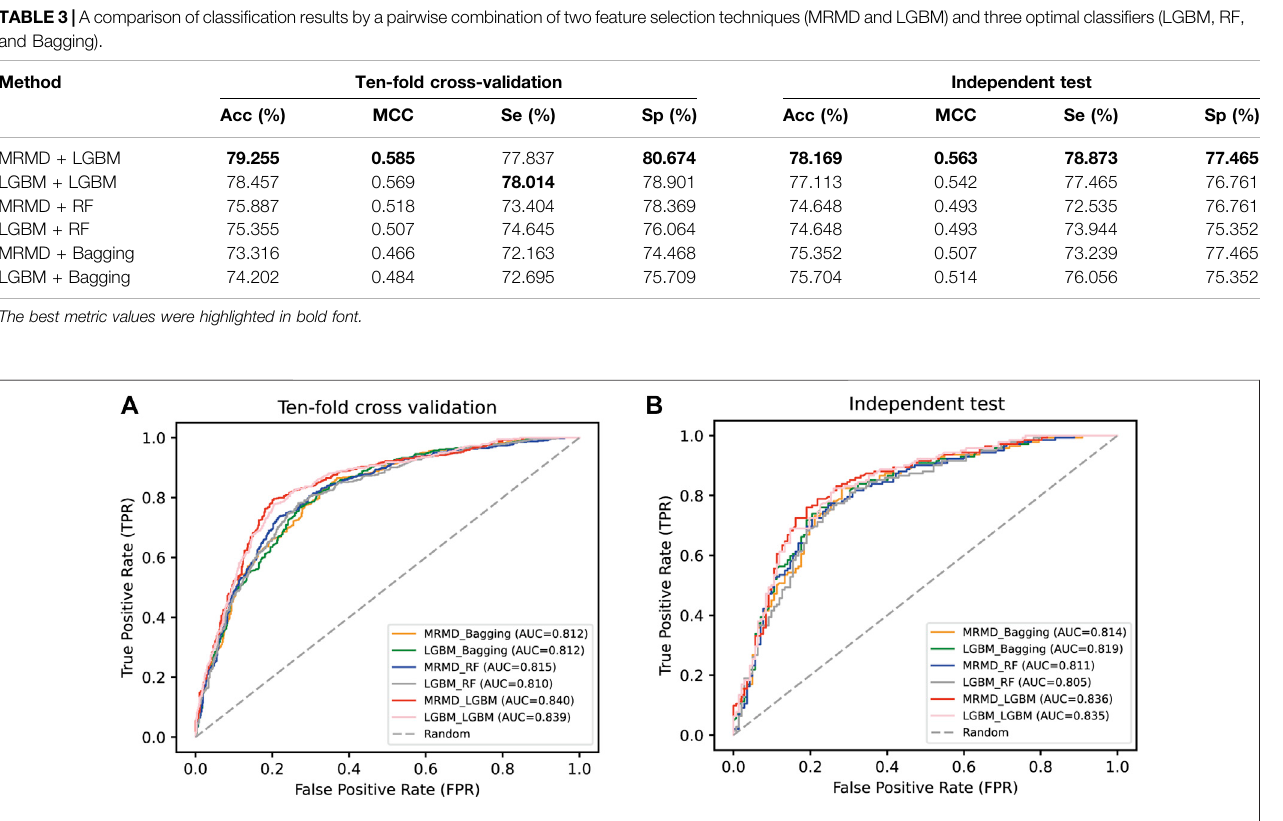
FIGURE 3 | A comparison of the AUC curve in ten-fold cross-validation (A) and independent test (B) . Results were by a pairwise combination of two feature selection techniques (MRMD and LGBM) and three optimal classi fi ers (LGBM, RF, and Bagging).